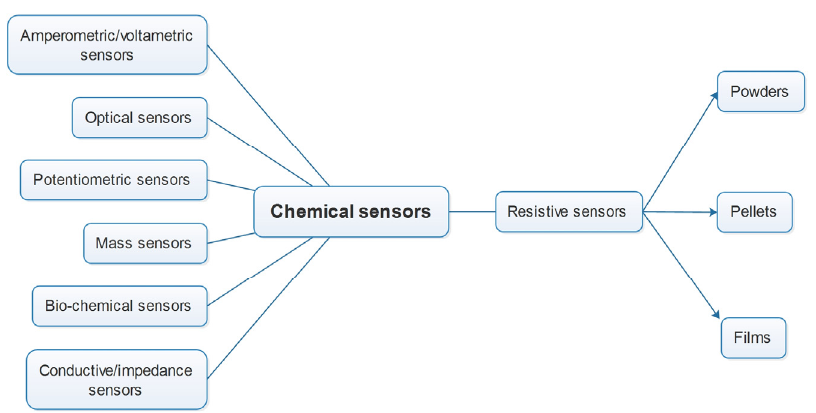
Figure 1. Types of chemosensors used in modern